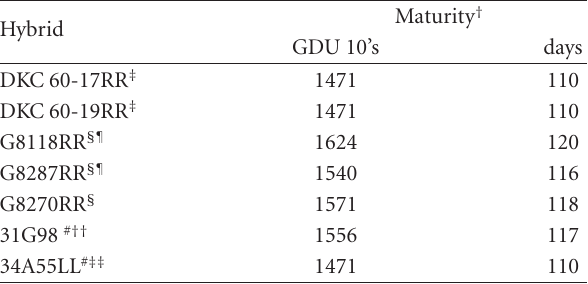
Table 1: Hybrids Used to Evaluate E ff ects of Herbicides on Corn Growth and Development at Stoneville,